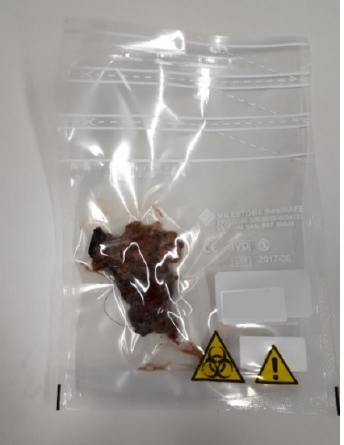
Figure 3. Example of a cervical lymphadenectomy specimen vacuum-sealed with the TissueSAFE plus device (Milestone, Sorisole, Italy).